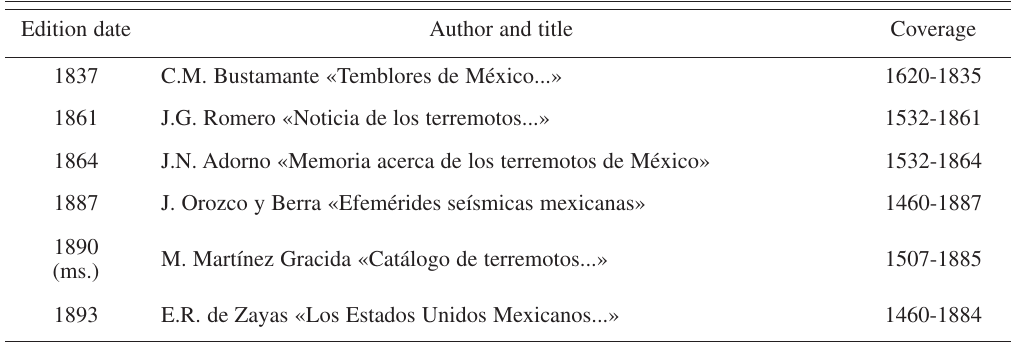
Table I. 19th Century nation-wide Earthquake